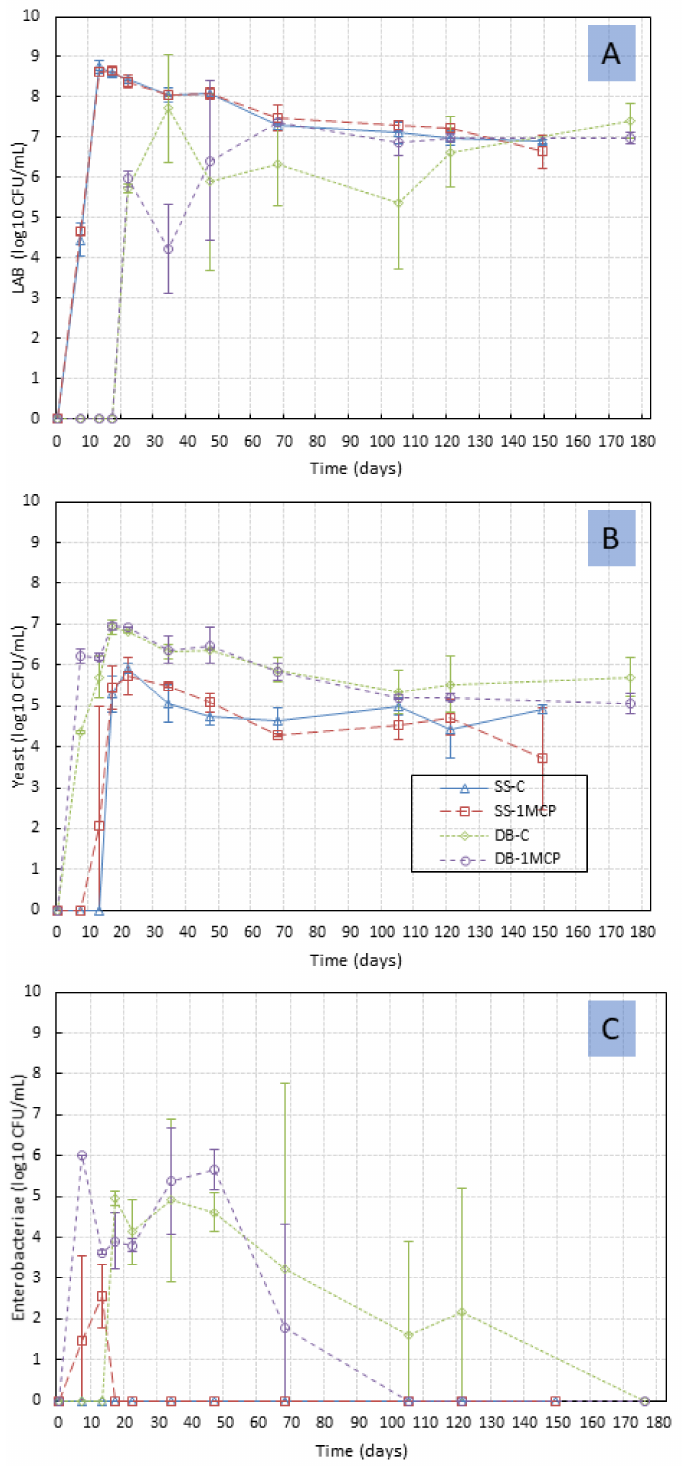
Figure 4. Evolution in brines of LAB ( A ), yeasts ( B ), and Enterobacteriaceae ( C ) populations during fermentation in the different treatments assayed in this work. DB-C: control directly brined olives, DB-1MCP: directly brined olives treated with 1-MCP, SS-C: control Spanish-style olives, SS-1MCP: Spanish style olives treated with 1-MCP. Time 0 corresponds to the moment just after putting the fruits in brine fermentation. Non-overlapping error bars stand for significant differences among treatments according to ANOVA analysis and post hoc statistical LSD test using p ≤ 0.05 as the cut-off level of